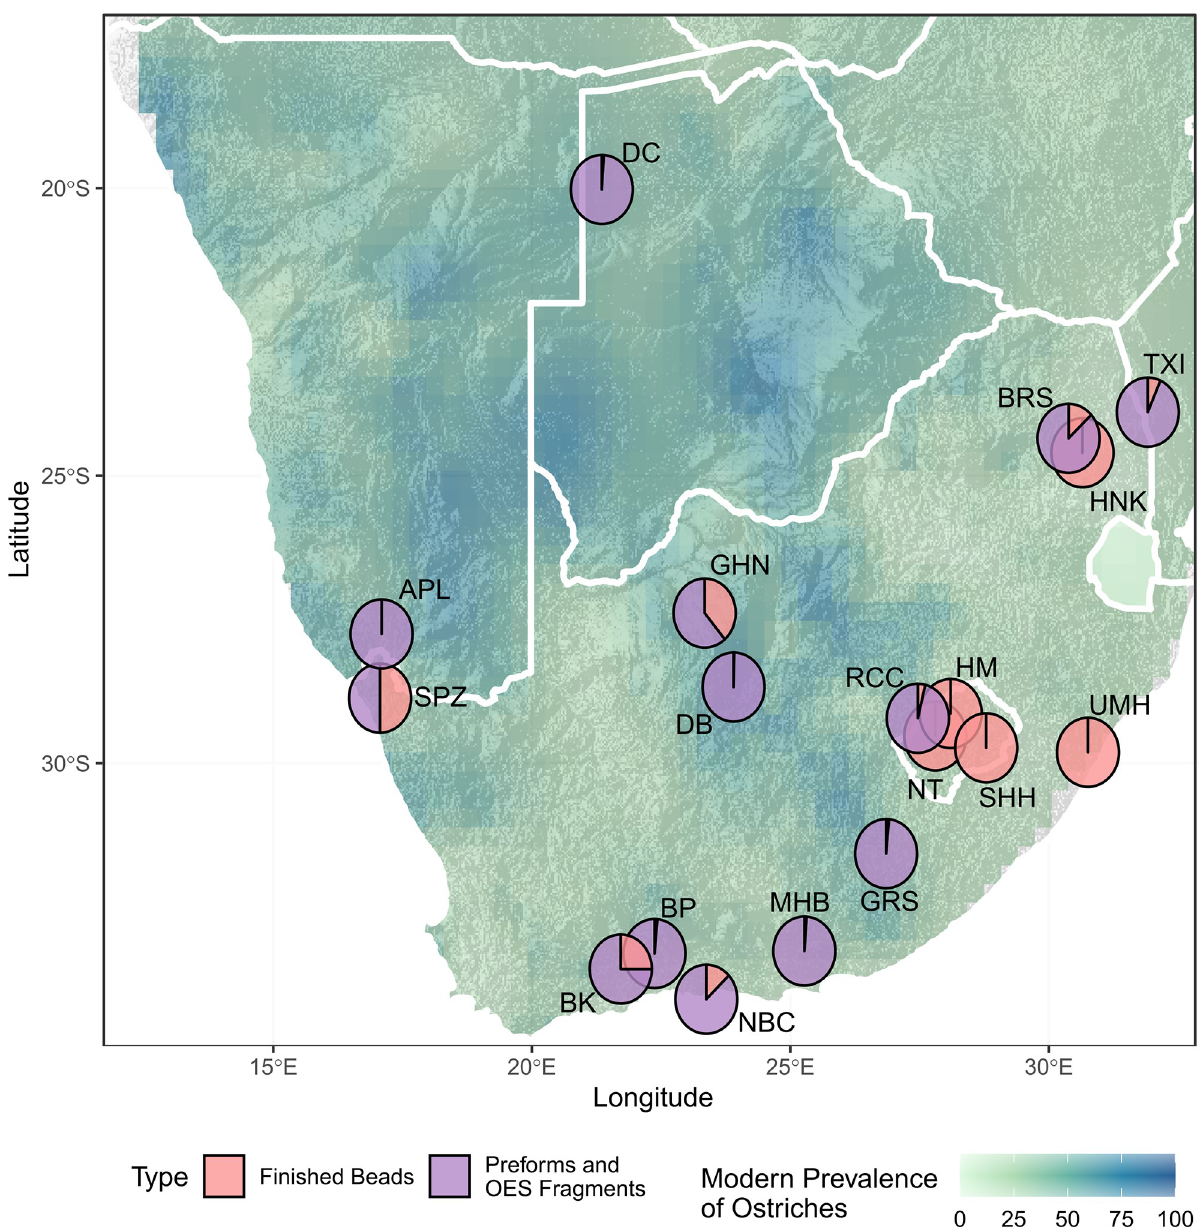
Fig 5. Map of southern Africa showing archaeological sites dated to MIS 2 that have OES bead assemblages. Pie charts show the proportion of finished beads to preforms and OES fragments at each site, overlaid on a map of modern ostrich prevalence based on South African Bird Atlas Project